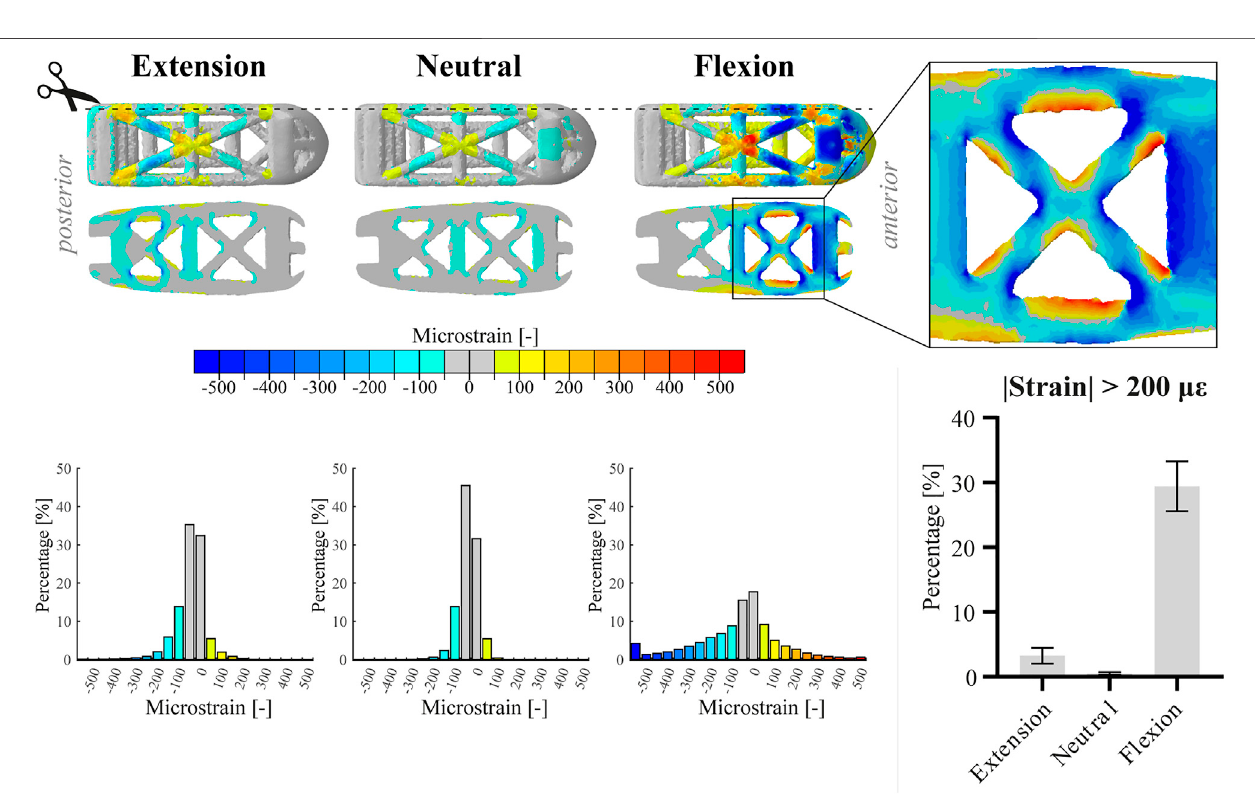
FIGURE 3 | Top part of the fi gure shows the absolute maximum principal strain values (top view and sagittal cut, respectively) on the right cage of patient 1 in extension, neutral, and fl exion position. Additionally, an enlarged view of the anterior part of the cage in fl exion is displayed. The three histograms correspond to the images above and represent the relative amount of surface nodes [%] for different strain ranges. For the bar chart, data of both cages within one patient were amalgamated.Thebarchartdisplaystherelativeamountofsurfacenodes[%]exceedinganabsolutestrainvalueof200µ ε forthedifferentloadingconditions.Bars represent the mean and 95% con fi dence interval of the patient population (n (cid:1) 4).